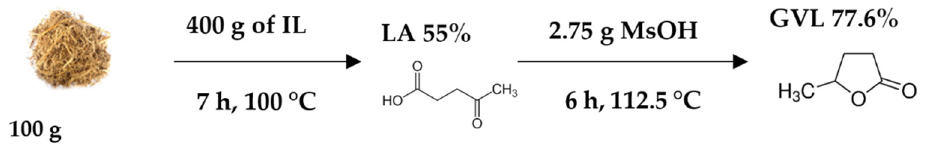
Figure 7. The process of GVL production from sugarcane bagasse.